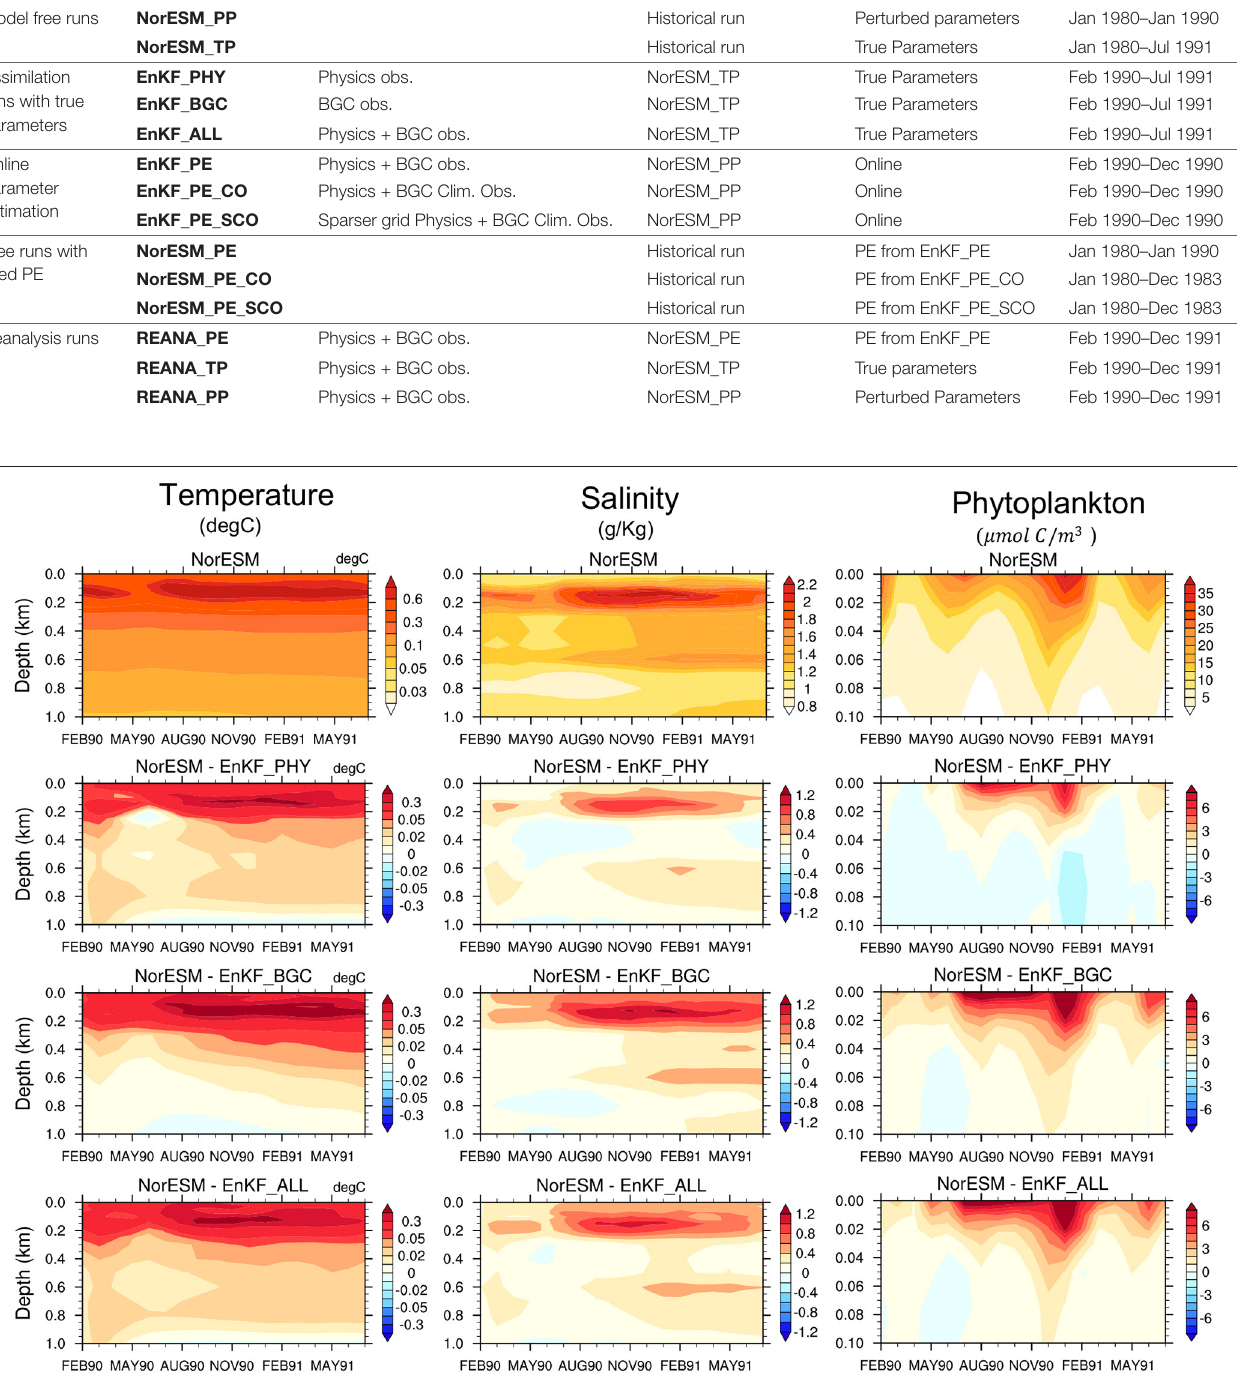
Frontiers in Marine Science |